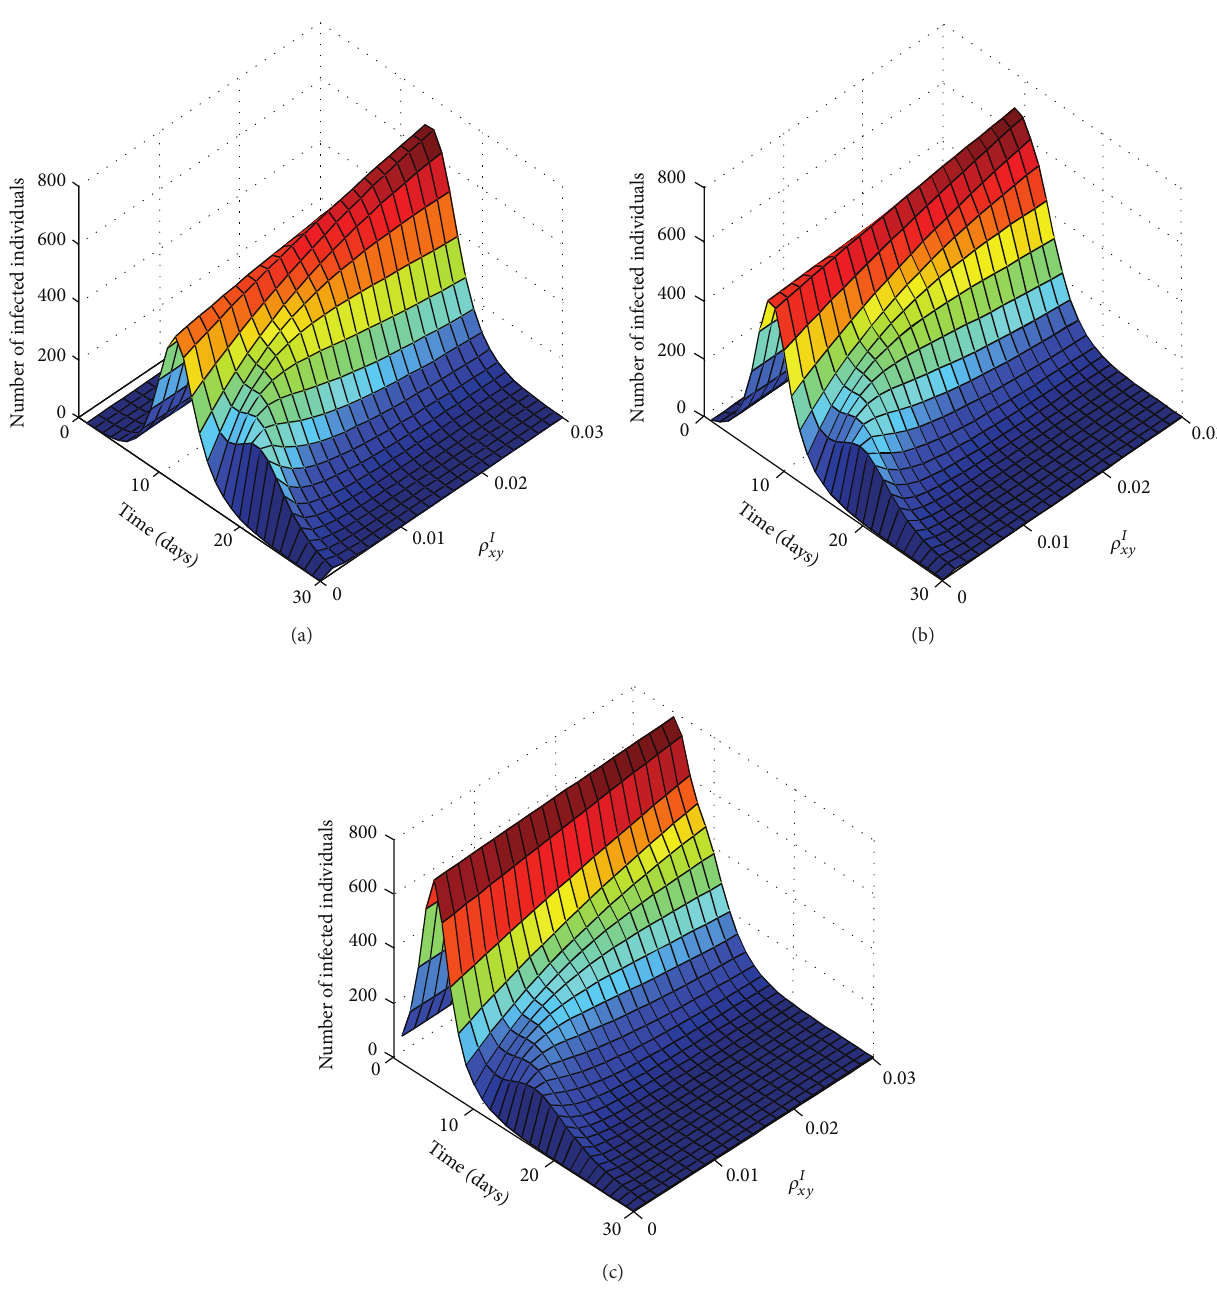
Figure 1: The impact of the variation in 𝜌 𝐼 𝑥𝑦 (here = 𝜏 𝐼 𝑥𝑦 ) on the total number of infected individuals along 30 days for different initial values of infected individuals in patch 𝑥 : (a) 𝐼 𝑥𝑥 0 = 1 , (b) 𝐼 𝑥𝑥 0 = 10 , and (c) 𝐼 𝑥𝑥 0 = 100 . Varying individuals’ flow intensity from one patch to another causes a notably increased appearance of infectives in the SIR model, due to the delayed entrance of infecteds. For this example we assume that patch 𝑦 is initially to be disease-free and that we are interested in controlling the flow of infected individuals towards it. Accordingly, we 𝑦𝑦 = 𝐼 𝑥𝑦 = 𝐼 𝑦𝑥 = 0 . The other initial values are 𝑆 𝑥𝑥 = 1,500 , 𝑆 𝑦𝑥 = 𝑆 𝑥𝑦 = 0 , and 𝑆 𝑦𝑦 = 1,000 . The parameter values are chosen from take 𝐼 0 0 0 a particular influenza episode modeled with an SIR scheme [20], 𝛽 = 10 −3 / day, 𝑑 = 0.44/ day. The values for the fractions of individuals moving between patches are chosen in a range estimated for patches with high interconnectivity [9]: 𝜏 𝑆 𝑥𝑦 = 𝜌 𝑆 𝑥𝑦 = 0.03 , 𝜏 𝑆 𝑦𝑥 = 𝜌 𝐼 𝑦𝑥 = 0.02 , and = 𝜌 𝐼 = 0.02 𝜌 𝑆 𝑦𝑥 𝑦𝑥